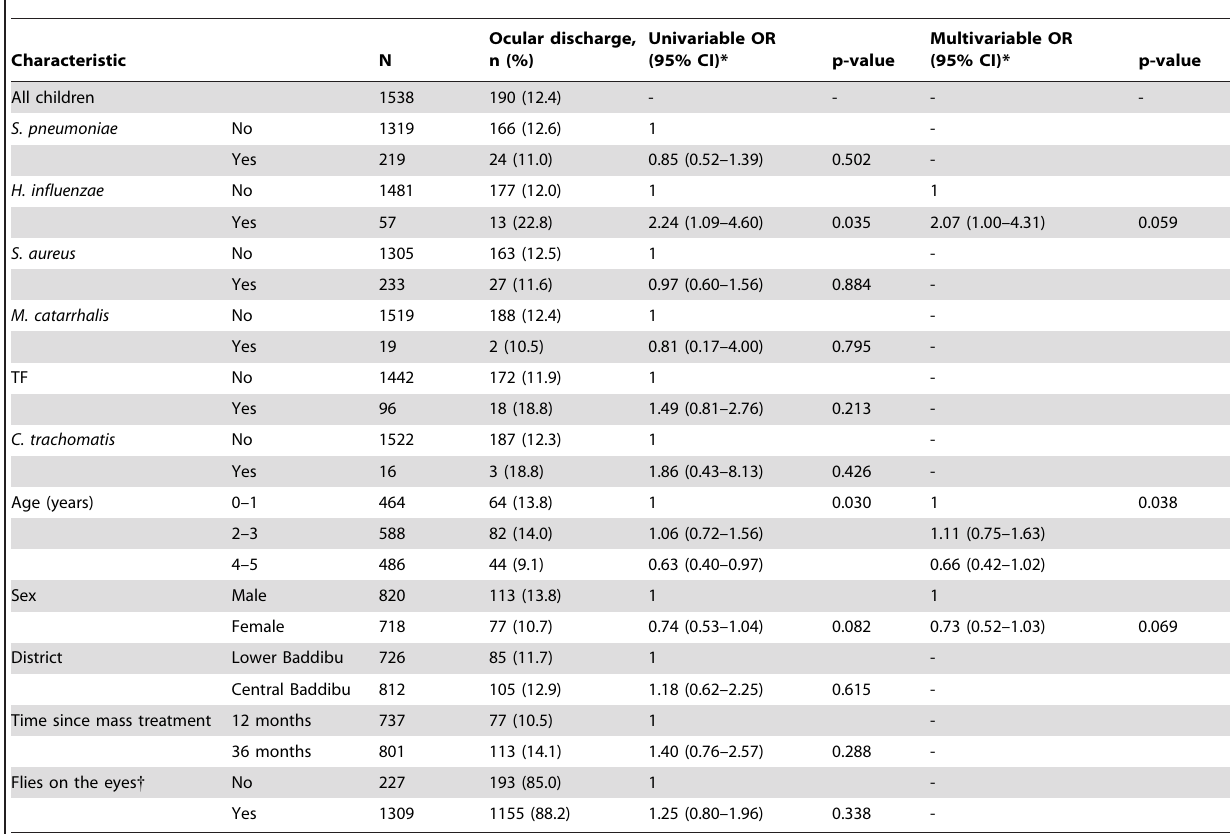
*Univariable and multivariable ORs are estimated from random effects logistic regression models accounting for between-household and between-EA variation, as appropriate. { 2 missing values for flies on the eyes.